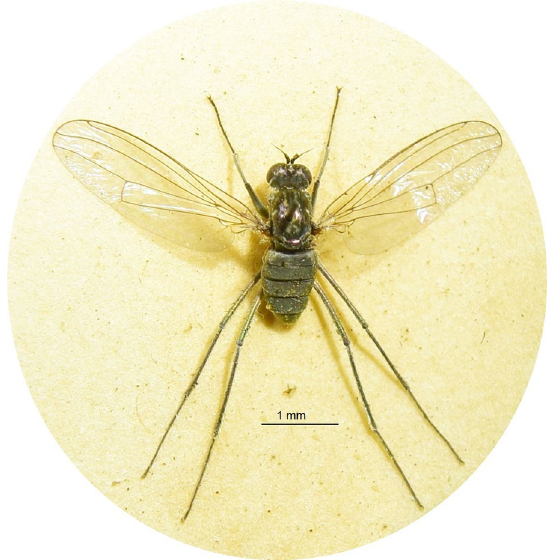
Fig. 5 Hydrophorus praecox (Lehmann) female habitus,